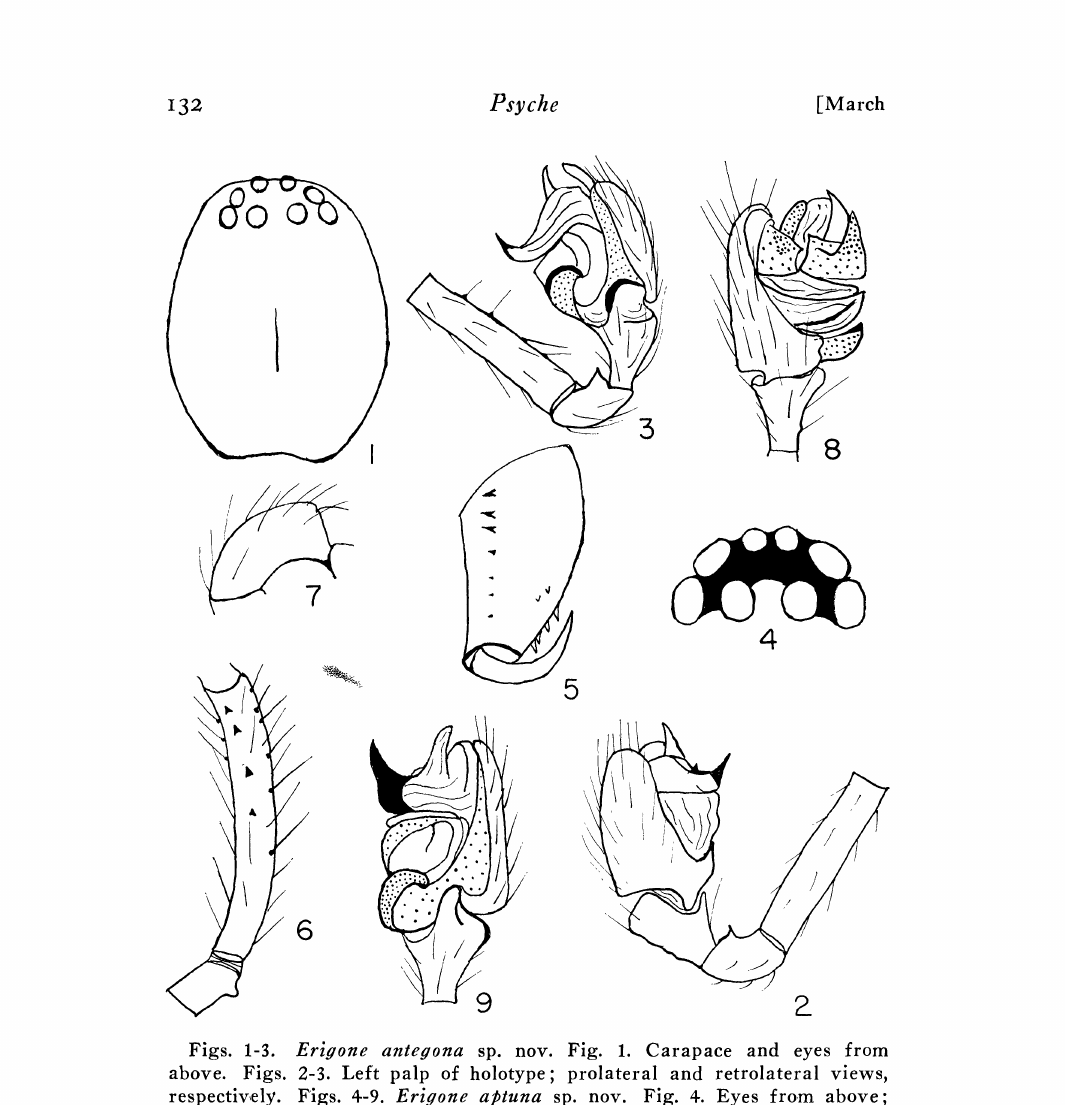
Figs. 1-3. Erigone antegona sp. nov. Fig. 1. Carapace and eyes from above. Figs. 2-3. Left palp of holotype; prolateral and retrolateral views, respectively. Figs. 4-9. Eriyone aptuna sp. nov. Fig. 4. Eyes from above; tipped backward slightly. Fig. 5. Right chelicera from in front. Fig. 6. Left p,alpal femur and trochanter; nearly ventral view. Fig. 7. Right palpal patella of holotype; retrolateral view. Figs. 8-9. left palpal tibia and tarsus; ’prolateral and retrolateral views,